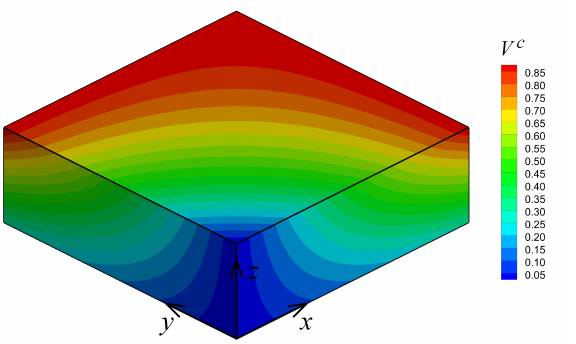
Figure 13. Contour plot of volume fraction distribution V c ( x , y , z ) for the optimum material parame- ters ( p 1 , p 2 ) = ( 0.3,0.9 ) for Example